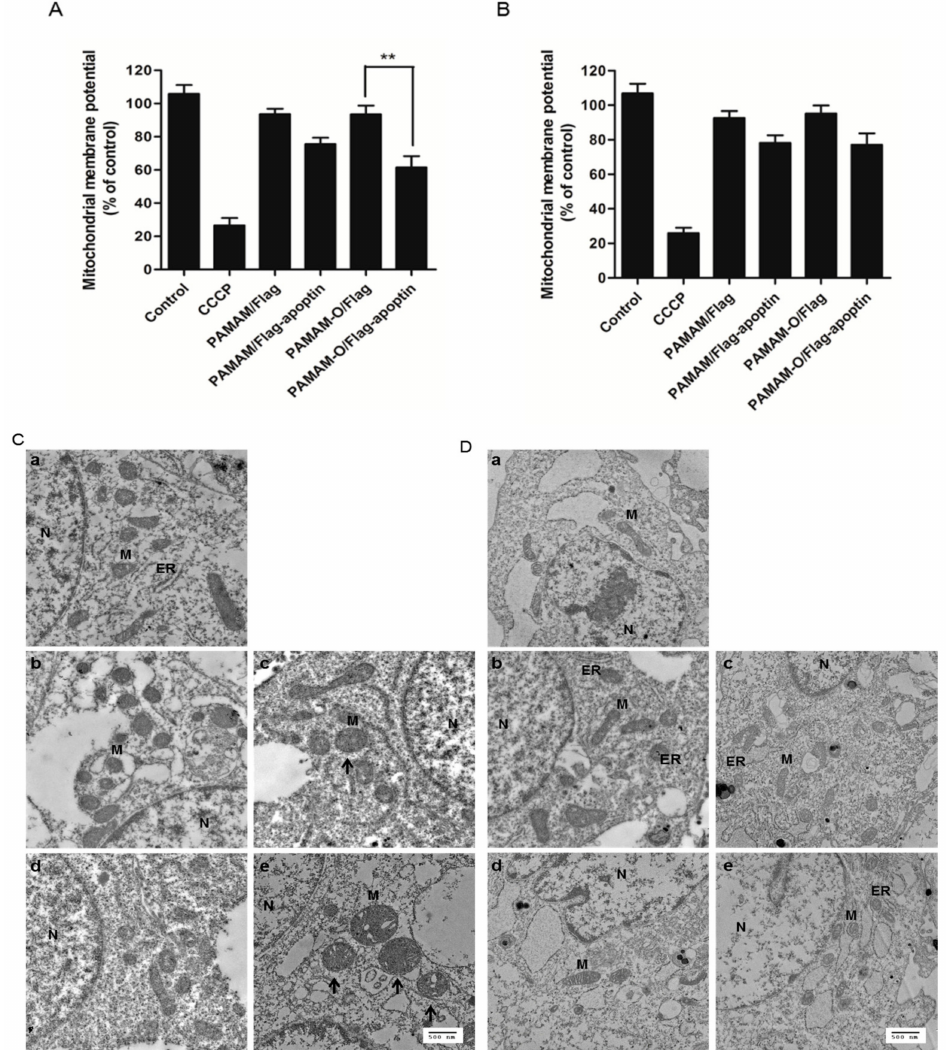
Figure 9. Mitochondria-mediated apoptosis by the PAMAM-O/Flag-apoptin polyplex. HepG2 cells ( A ) and dermal fibroblasts ( B ) were transfected with polyplexes of PAMAM and PAMAM-O dendrimers and 1 µ g of Flag or Flag-apoptin. The cells were stained with Tetramethylrhodamine, ethyl ester (TMRE), and the mitochondrial membrane potential (MMP) was analyzed by Fluorescence-activated cell sorting (FACS). The number in the bottom right quadrant represents the percentage of MMP loss. Carbonyl cyanide 3-chlorophenylhydrazone (CCCP) was used as the positive control. Asterisks show statistical significance. Unpaired t -test: ** p < 0.01. HepG2 cells ( C ) and dermal fibroblasts ( D ) were treated as in panels A and B. TEM imaging of mitochondrial structural changes: ( a ) control cell without polyplexes; ( b ) PAMAM/Flag; ( c ) PAMAM/Flag-apoptin; ( d ) PAMAM-O/Flag; and ( e ) PAMAM-O/Flag-apoptin. N: nuclei, M: mitochondria, and ER: endoplasmic reticulum. Black arrows indicate changes in mitochondrial morphology. The scale bar is 500